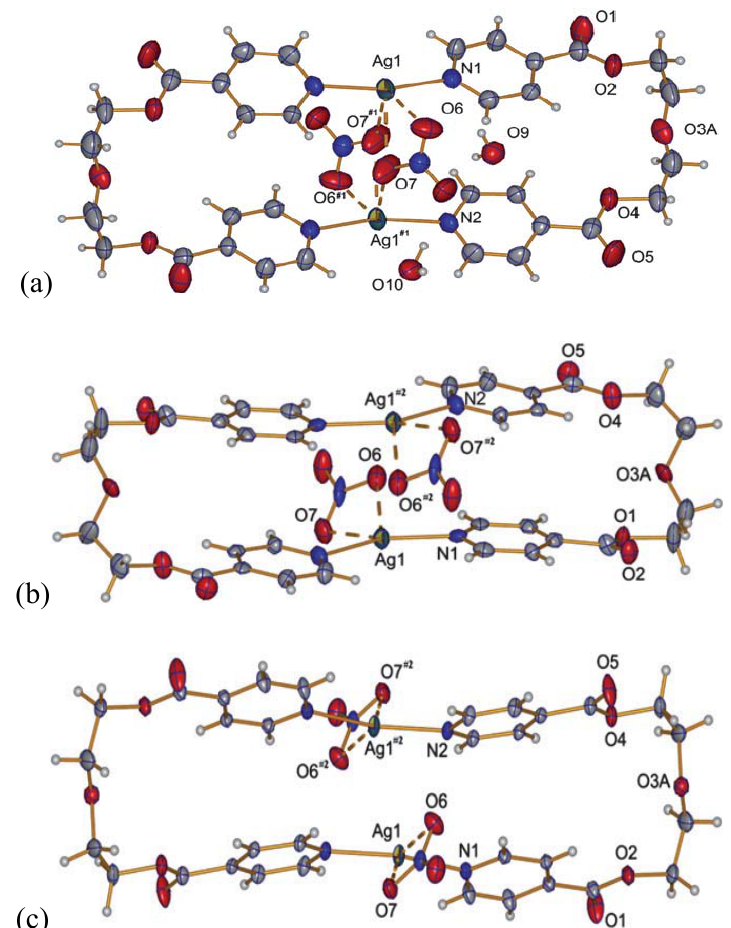
Figure 10. Metalla-cycles formed in compounds 10 (a), 11 (b) and 12 (c).